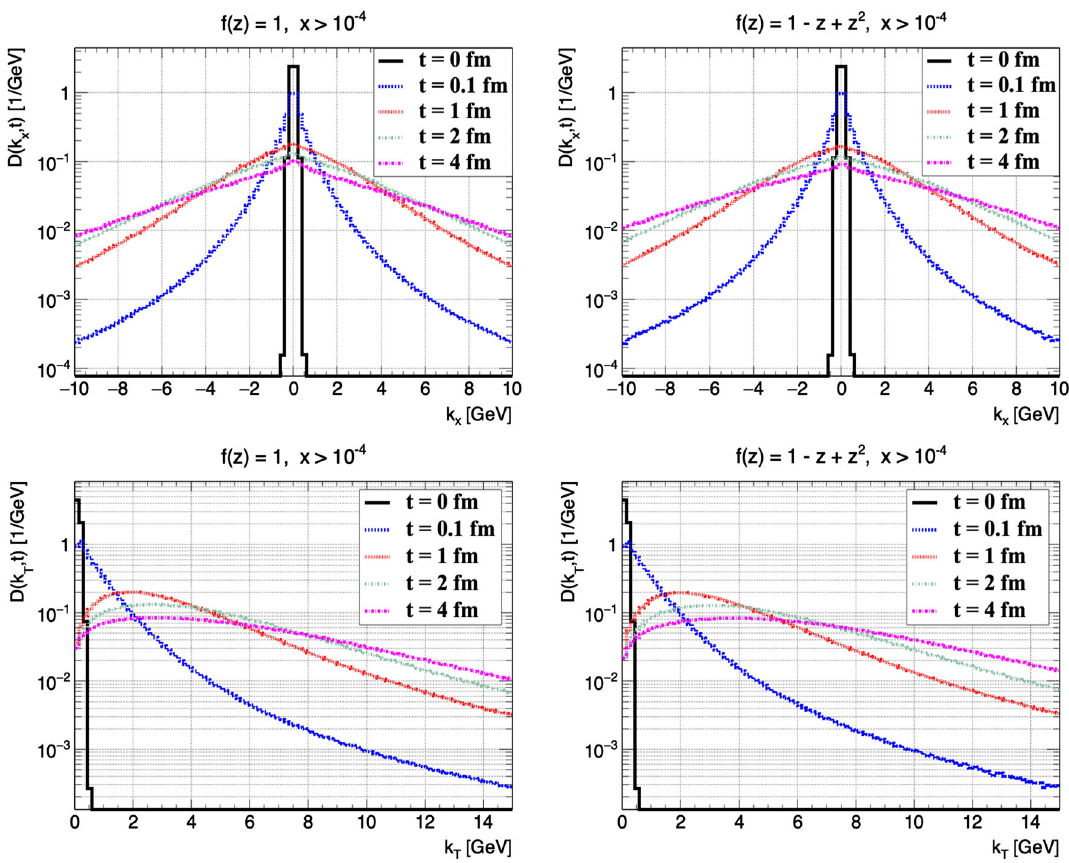
Fig. 4 The k x and k T distributions from the Monte Carlo program MINCAS for the evolution time values: t = 0 , 0 . 1 , 1 , 2 , 4fm. The LHS figures are for the simplified z -kernel function, while the RHS ones for the exact one